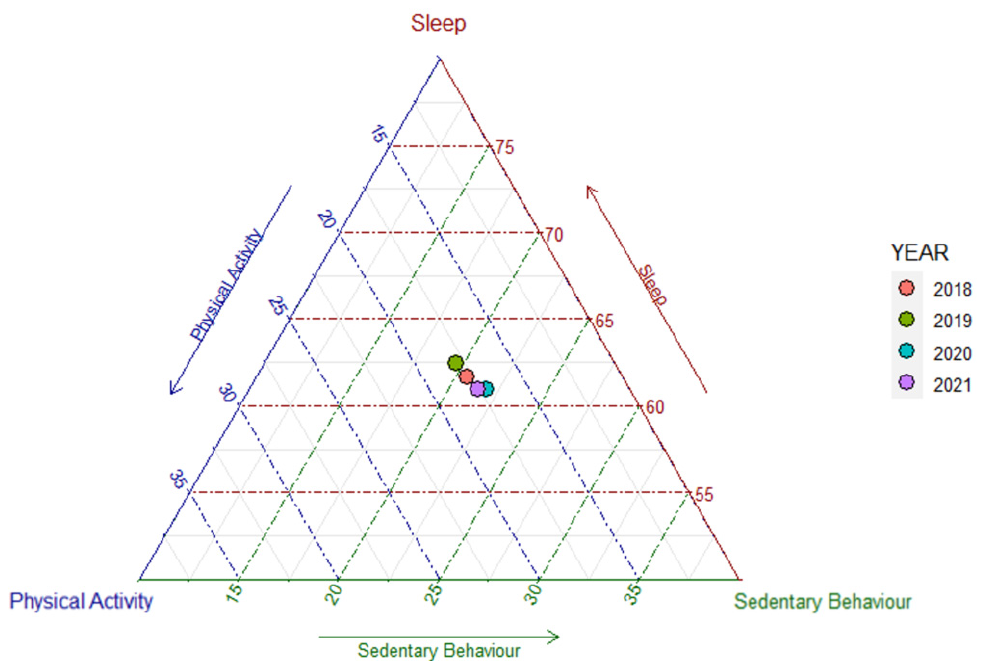
Figure 1. Ternary plot of the sample composition of time spent in PA, SB, and SL from year 2018–2021. Different coloured points represent the different years, the red point represents 2018; the green point represents 2019; the blue point represents 2020; and the purple point represents 2021.